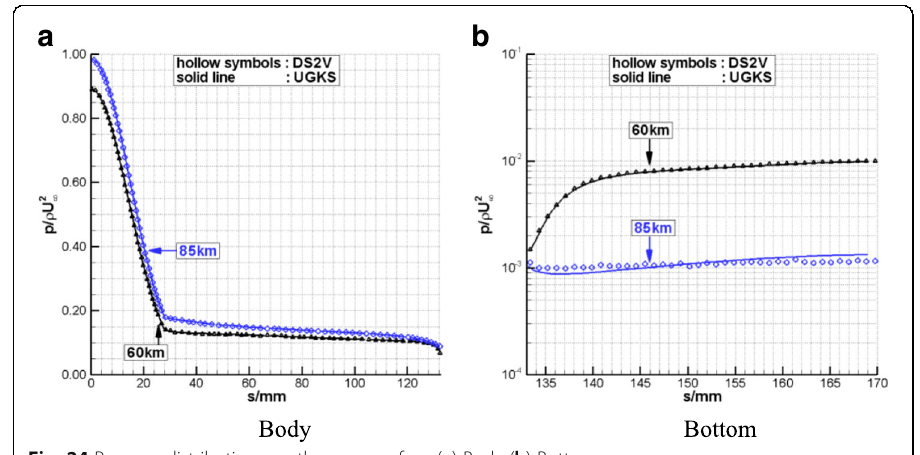
Fig. 24 Pressure distributions on the cone surface ( a ) Body ( b )